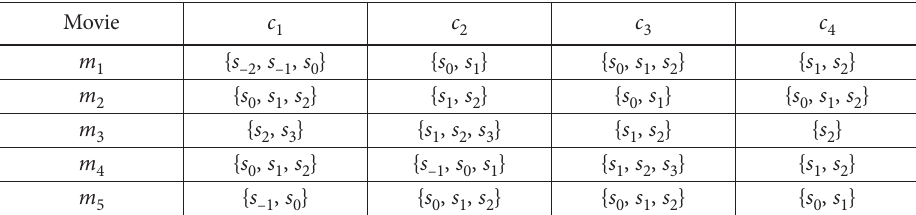
Table 1. The hesitant fuzzy linguistic judgment matrix provided by decision organization